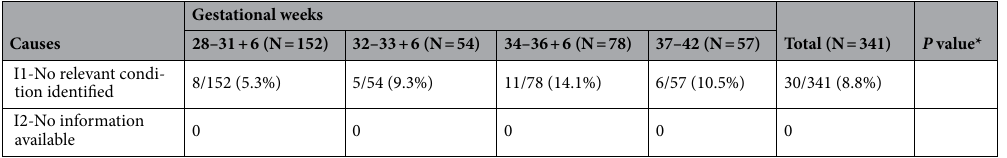
Table 5. Distribution of stillbirth causes in different gestational weeks. Data are n/N (%) for cases. The criteria used for categorization are based on the ReCoDe classification system. *Comparison of different gestational